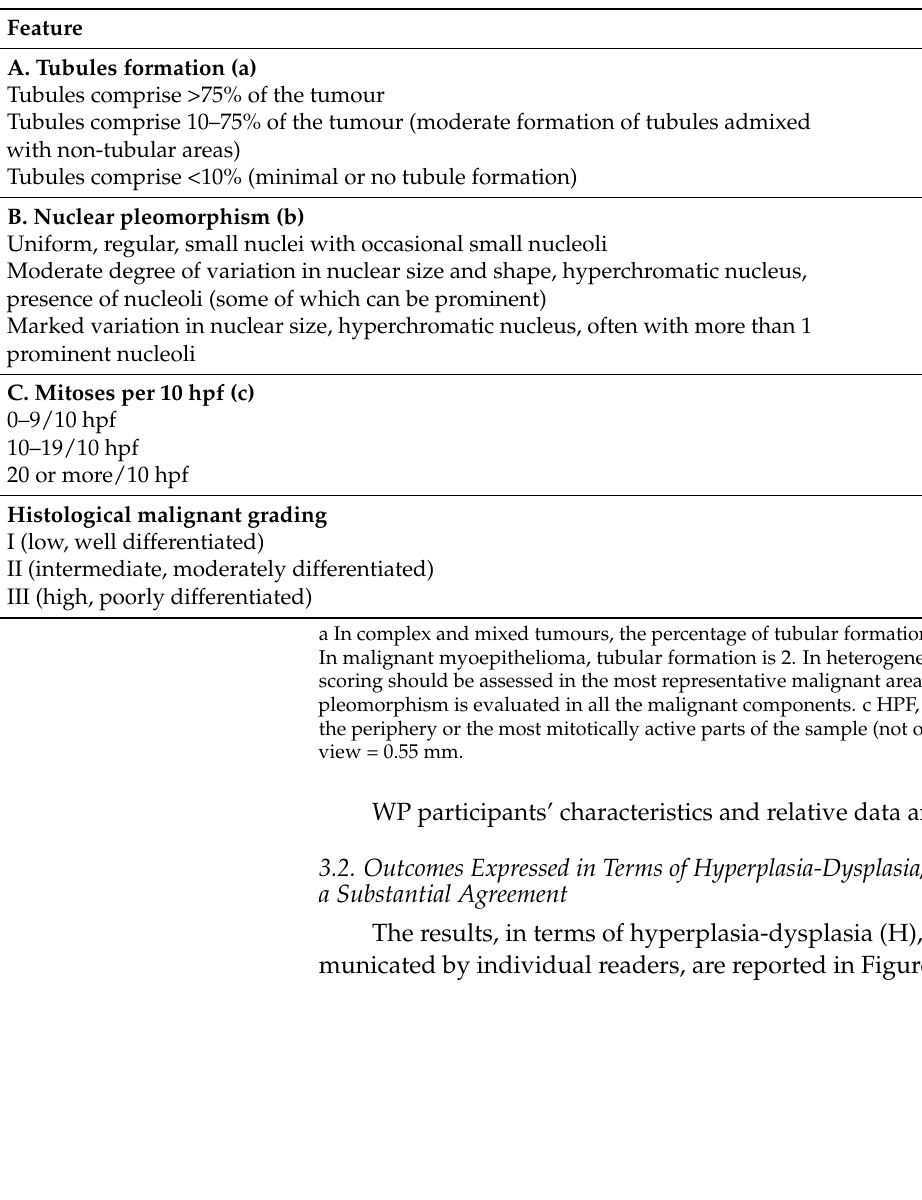
Table 3. Histological grading for canine mammary tumours [2]. Main categories used for grading are indicated in